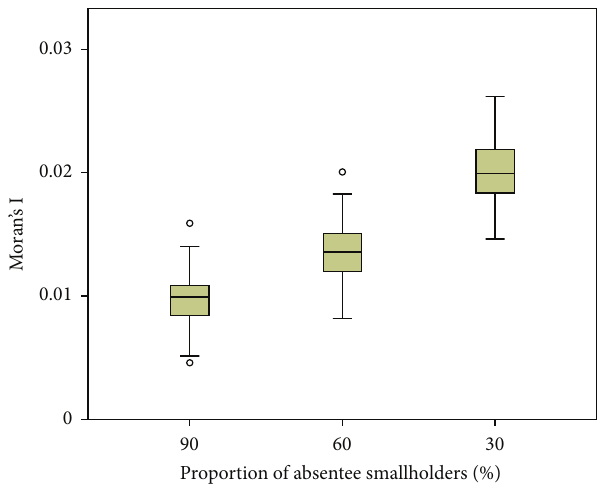
Figure 8: Land use and land cover change clustering (measured using Moran’s I for spatial autocorrelation at the landscape scale) increases significantly with a decrease in smallholder absenteeism.